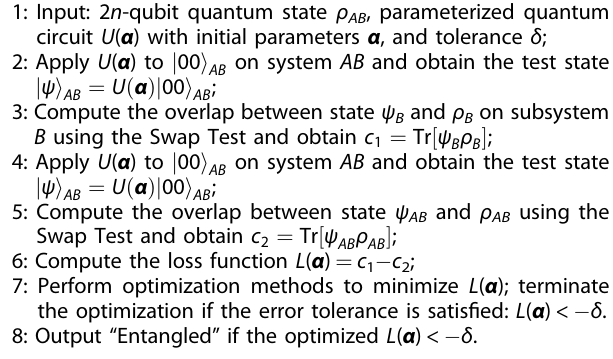
Algorithm 3 . Improved VED based on reduction criterion 1: Input: 2 n -qubit quantum state ρ AB , parameterized quantum circuit U ( α ) with initial parameters α , and tolerance δ ;